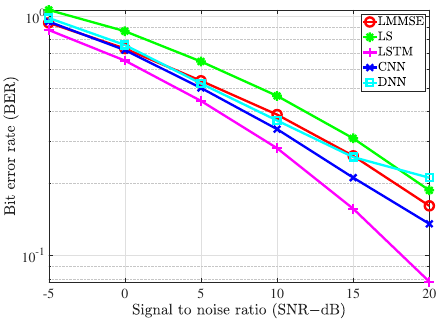
Figure 14. The BER of the channel estimate vs. the SNR level with f D = 200